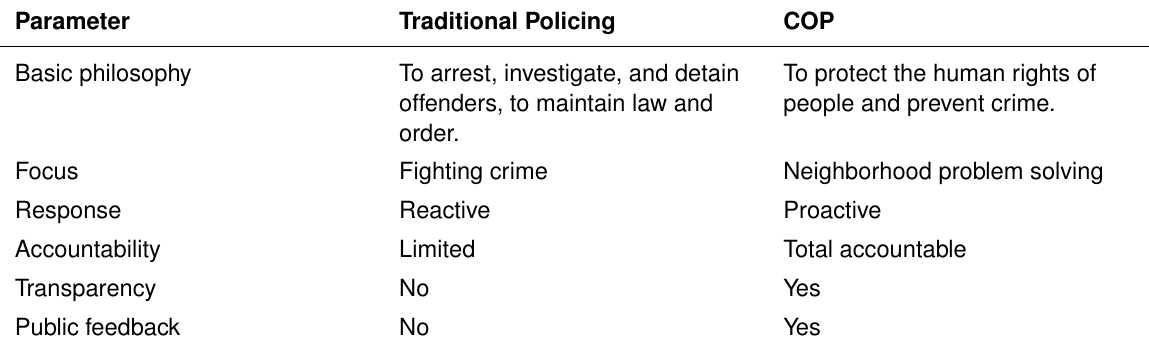
Table 1. Comparison of traditional policing and COP